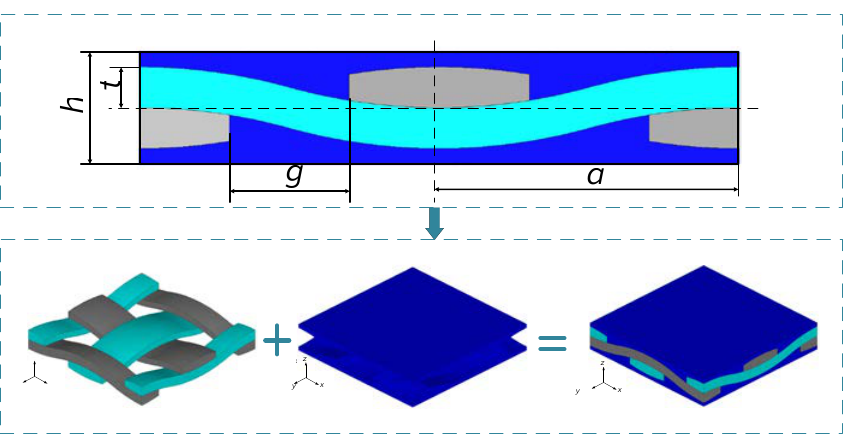
Figure 4. Meso-model of 2D SiC/SiC CMCs. Table 1. Meso-geometric parameters of 2D SiC/SiC CMCs.